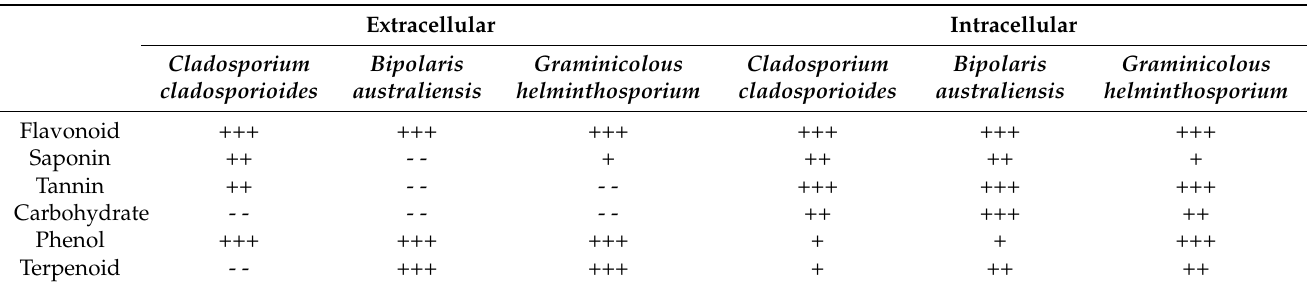
Table 3. Phyto-chemical analysis of both extracellular (ethyl aceteate) and intracellular (methanol mat) extracts of Graminicolous helminthosporium, Bipolaris australiensis, and Cladosporium cladosporioides. Extracellular